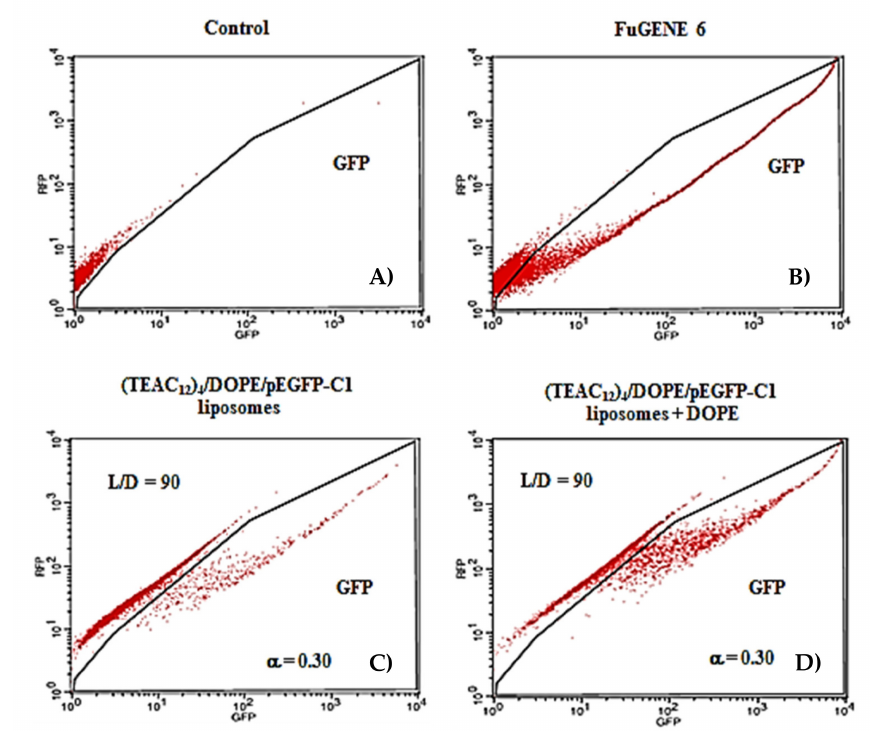
Figure 10. FACS analysis of cells transfected with 3 µ g of p-EGFP-C1 for the different reagents. The charts show green fluorescent emission (X axis) vs. red fluorescent emission (Y axis) of 10,000 live cells analyzed per condition 24 h post-transfection. The GFP gate defines the area where cells with a clear increase in their green fluorescent emission are observed without a parallel increase in their red fluorescent emission. ( A ) Control; ( B ) FuGENE 6; ( C ) (TEAC 12 ) 4 /DOPE/pEGFP-C1 liposomes at α = 0.30 for L/D = 90; and ( D ) (TEAC 12 ) 4 /DOPE/pEGFP-C1 liposomes + DOPE at α = 0.30 for L/D = 90.